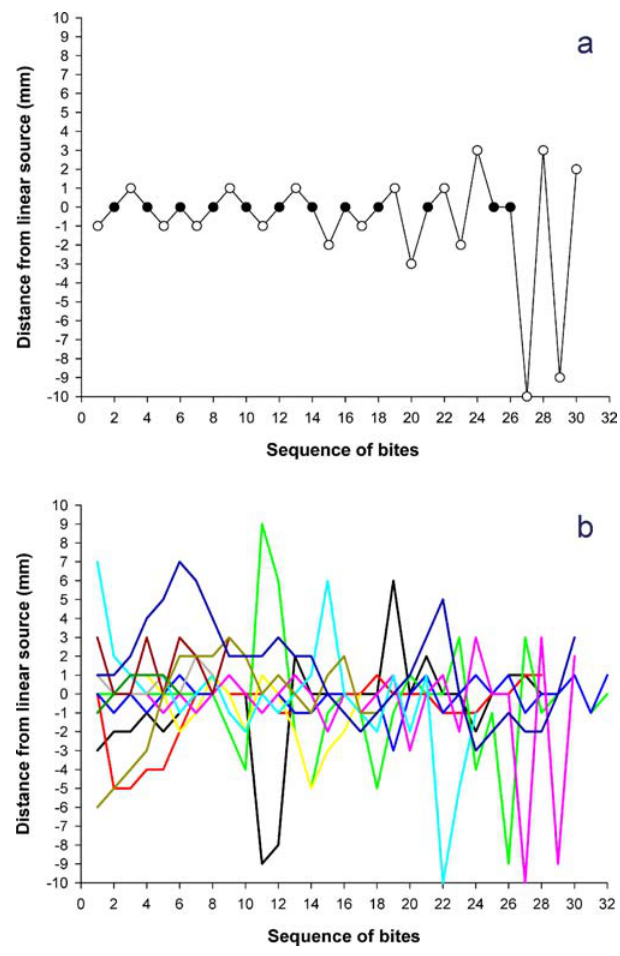
Figure 2. Sample records of the distance from an initial sequence of bites to the linear thermal source, performed by insects in an assay in which the linear source was 3 u C warmer than the background. a , Sample record corresponding to a single insect; black circles represent direct contacts with the heated wire. b , The distribution of bites performed by several insects, showing the location of the spots contacted in consecutive biting attempts. Each sequence represents approximately one attempts (Figure 3). If one input is abolished by unilateral